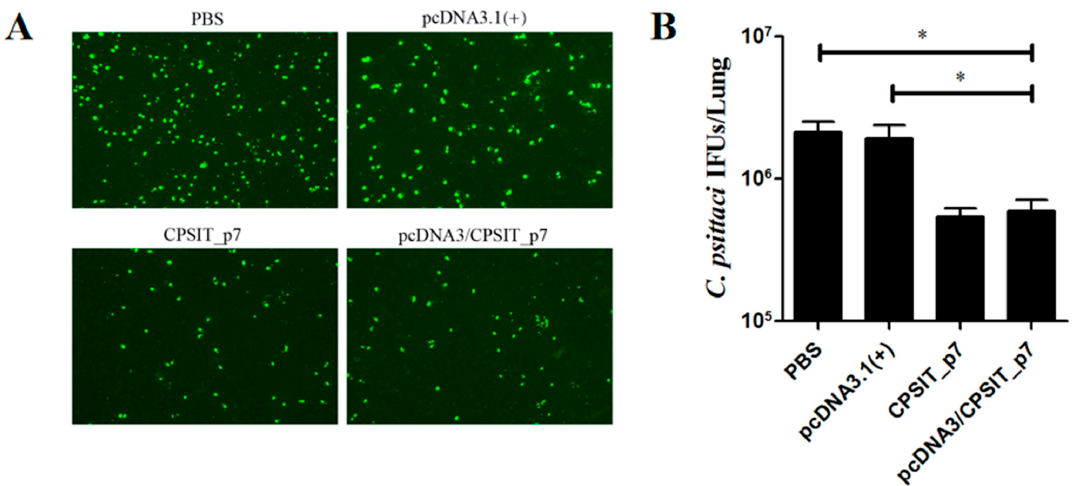
Figure 3. The C. psittaci load in the lungs of mice injected with a different vaccine after the C. psittaci challenge. The supernatants of lung homogenates of immunized mice were collected 10 days after being challenged intranasally with 5 × 10 5 IFUs of C. psittaci . ( A ) The immunofluorescent images of HeLa cells incubated with the supernatants of lung homogenates. In order to visualize the C. psittaci inclusions, samples were stained with rabbit anti- C. psittaci sera (green). ( B ) The number of inclusions expressed as IFUs. Each bar indicates the mean ± standard deviation of the C. psittaci titers (IFU/lung) in the lung homogenates from six mice per group in three independent data points. * p < 0.05.